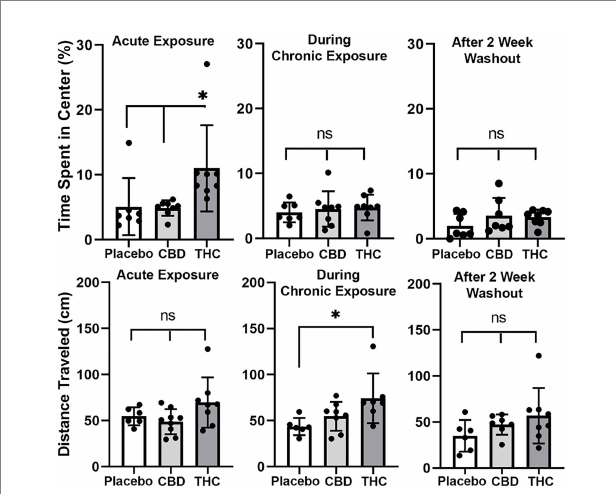
FIGURE 3 Open field. The scatter plots above show the percentage of time spent in the center of the open field during first exposure (Acute Exposure) to inhaled cannabis high in CBD, Δ 9-THC, or placebo and again at D26 of the 28 days of chronic exposure and following a two-week washout. Below is the distance traveled in the open field for each of the experimental conditions at each time point. The bar and line represent the mean and SD, respectively. ( * p <